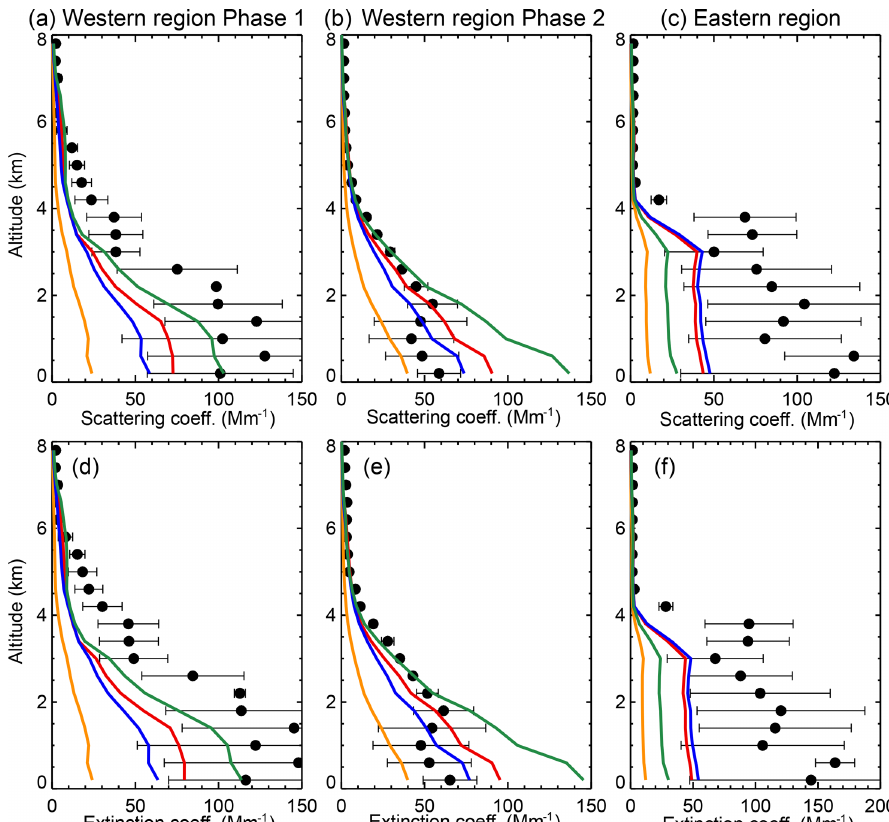
Figure 9. Vertical profiles of observed (black) and simulated (colour) aerosol scattering coefficient at 550nm (a, b, c) and extinction coef- ficient at 550nm (d, e, f) during the SAMBBA aircraft campaign, sectioned into 400m altitude bins. Observations are shown by the black data points. Simulated concentrations are shown for the model with FINN1.5 (green), GFAS1.2 (blue), GFED4 (red) emissions and with no biomass burning emissions (orange). The simulated data (linearly interpolated to the flight track of the aircraft) and the observations are split into western and eastern regions of the Amazon (Fig. 2), as well as by time (Phase 1: 13–22 September 2012, Phase 2: 23 September–3 Oc- tober 2012) for the western region. Error bars show the standard deviation of the observed mean. The NMBF values are given separately for the western region (Phase 1 and Phase 2) and eastern region in Table